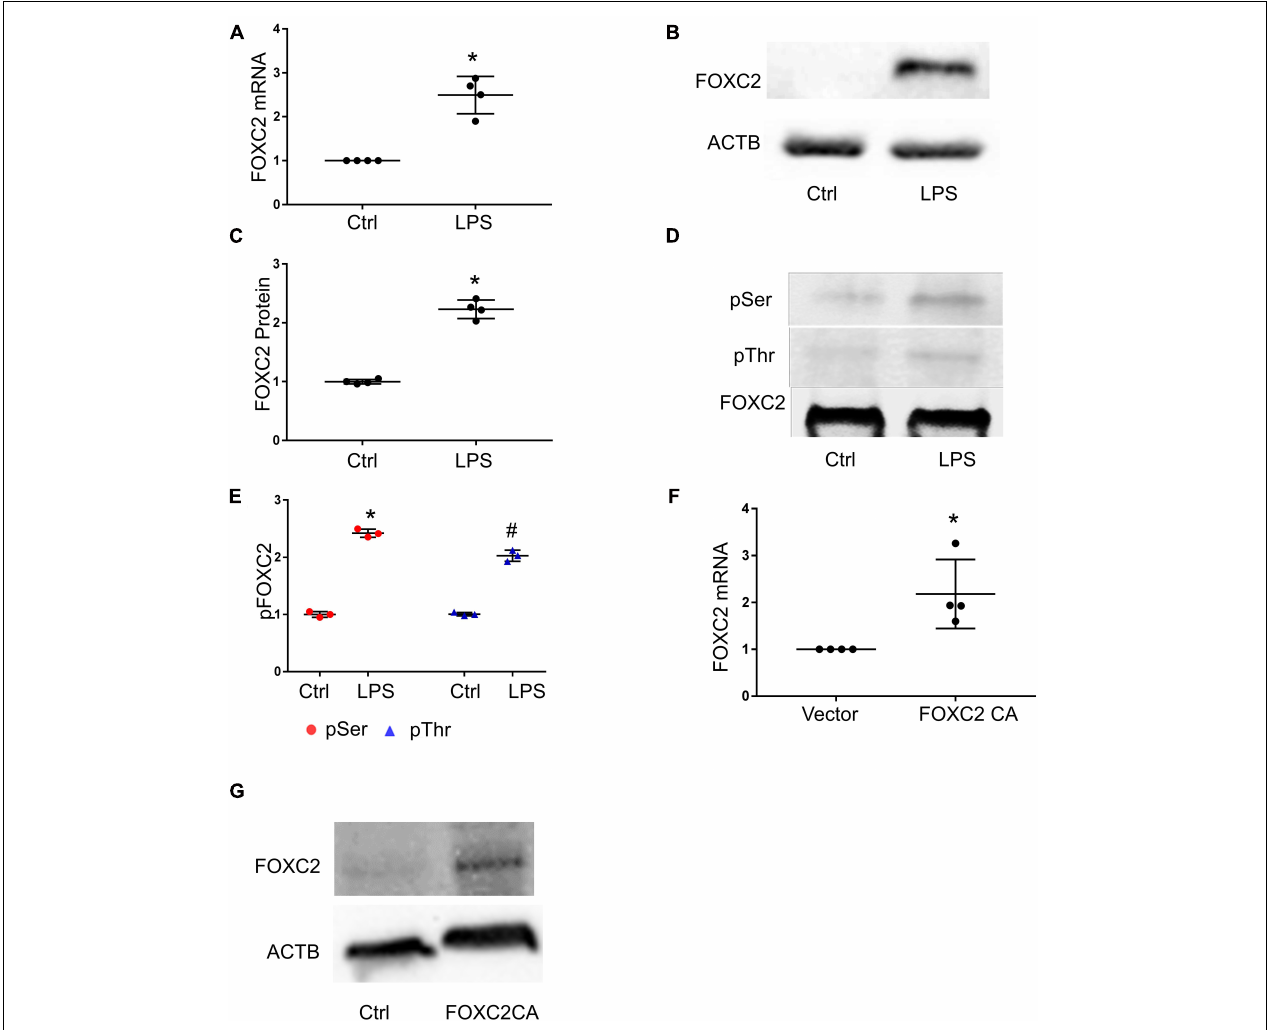
FIGURE 1 | FOXC2 expression is upregulated by LPS and FOXC2 CA in HMPEC-Im. (A) FOXC2 mRNA was assessed by qRT-PCR 4 h after 0.5 µ g/ml LPS treatment. n = 4 per group; * p < 0.01, LPS vs. Ctrl. (B) FOXC2 protein was quantified by immunoblotting after overnight 0.5 µ g/ml LPS treatment, with densitometry shown graphically (C) . n = 4 per group; * p < 0.05, LPS vs. Ctrl. (D) FOXC2 protein was immunoprecipitated from cell lysates at 30 min after LPS, and serine and threonine phosphorylation was assessed by immunoblotting, with densitometry shown graphically (E) . n = 3 per group, * p < 0.0001, LPS pSer vs. Ctrl pSer; # p < 0.005, LPS pThr vs. Ctrl pThr. (F) Cells were collected 2 days after transfection of FOXC2C CA plasmid and empty control plasmid respectively, and FOXC2 mRNA was quantified. n = 4 per group; * p < 0.05, FOXC2 CA vs. vector. (G) Immunoblotting showed FOXC2CA stimulated FOXC2 expression.